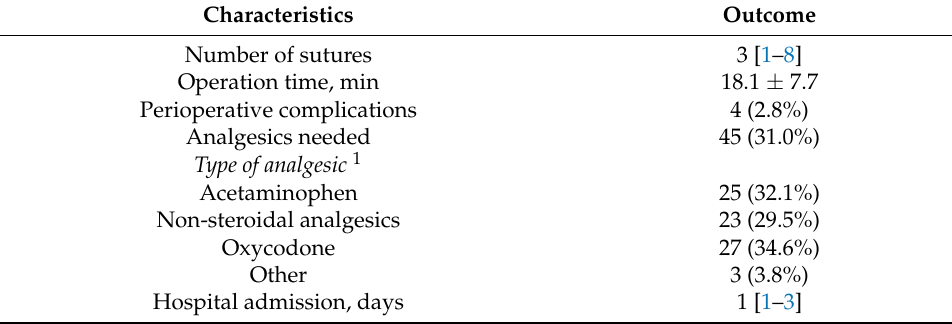
Table 2. Treatment characteristics and perioperative results ( n = number, y = years).